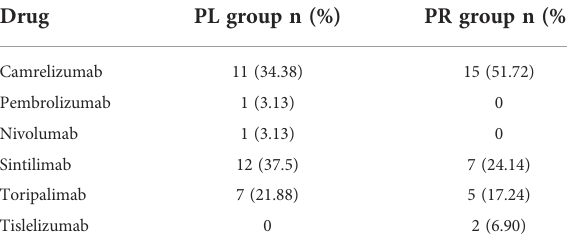
TABLE 2 The type of immune checkpoint inhibitors(ICIs).